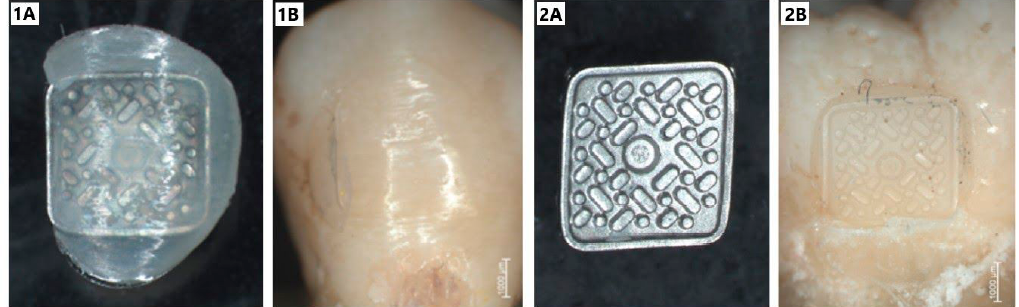
Figure 5. Comparison of examples of tooth surface and bracket surface with adhesive residue, adhesive damage of tooth-adhesive-bracket complex; ( 1A , 1B ) example surface of G1 group, conditioned with Er:YAG laser ( τ = 6.38 MPa); ( 2A , 2B ) example surface of G3 group ( τ = 10.13 MPa).